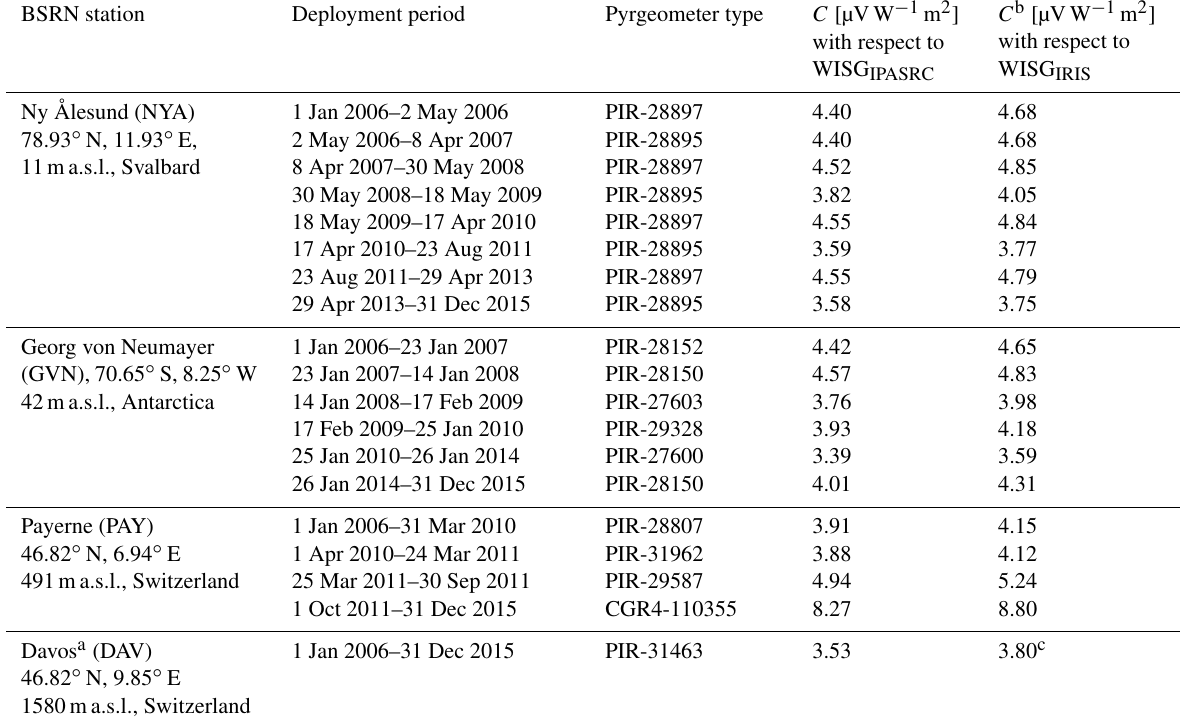
Table 1. Details of the station locations, pyrgeometers used and sensitivity ( C ) values with respect to the WISG IPASRC and WISG IRIS reference